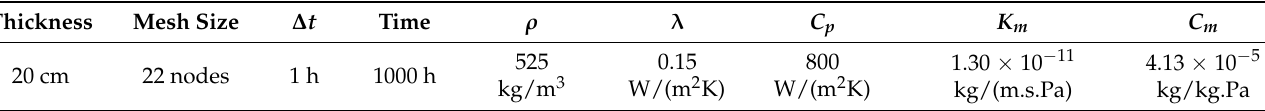
Table 1. Simulation input parameters for the N°2 HAMSTAD WP2 test [25]. Thickness Mesh Size ∆ t